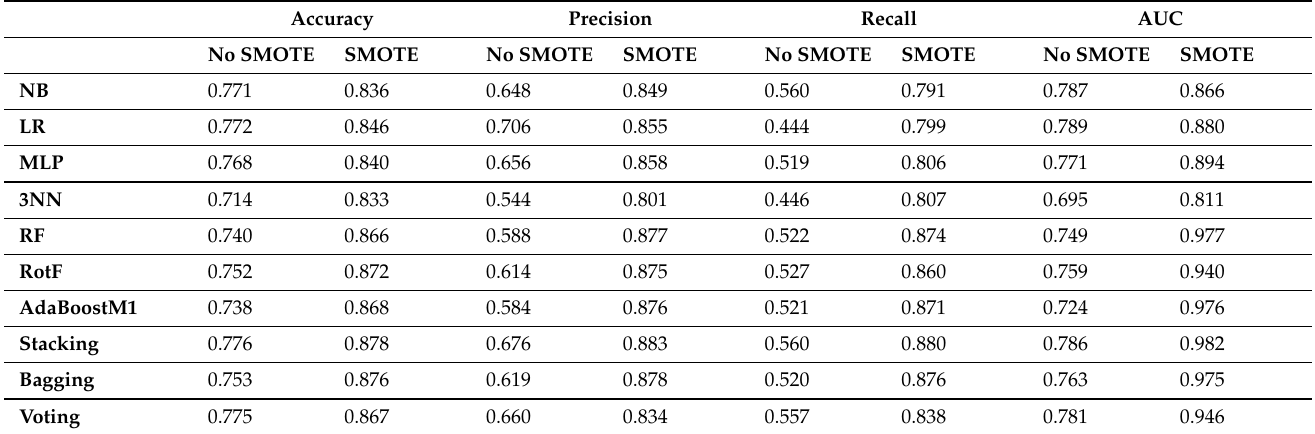
Table 10. Performance Evaluation of ML models before and after